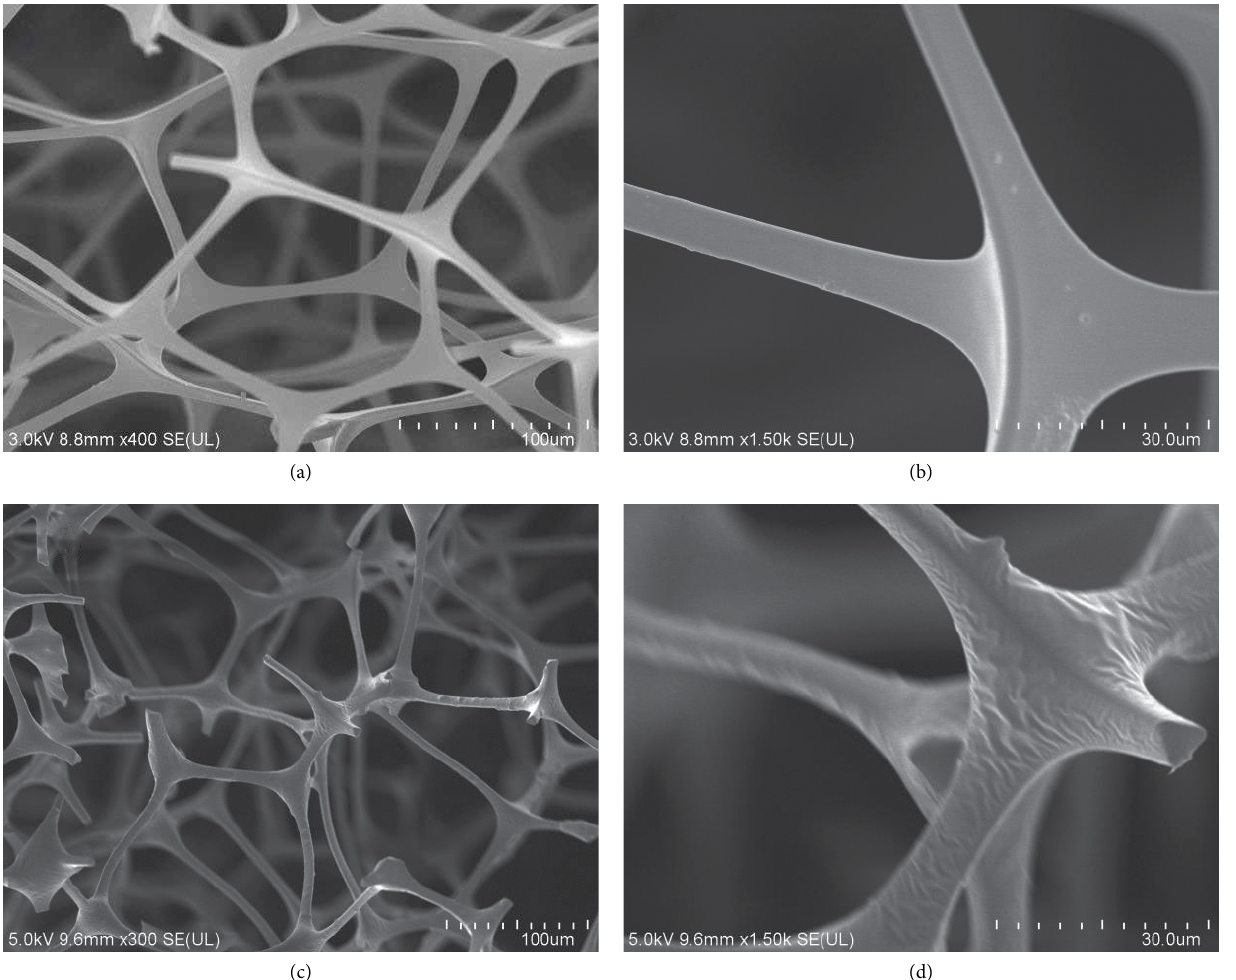
Figure 3: (a, b) SEM images of a pristine melamine sponge and (c, d) PDMS-SP modified melamine